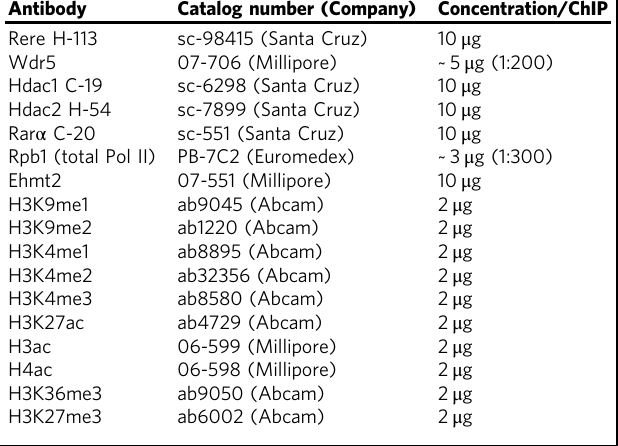
Antibody Catalog number (Company)